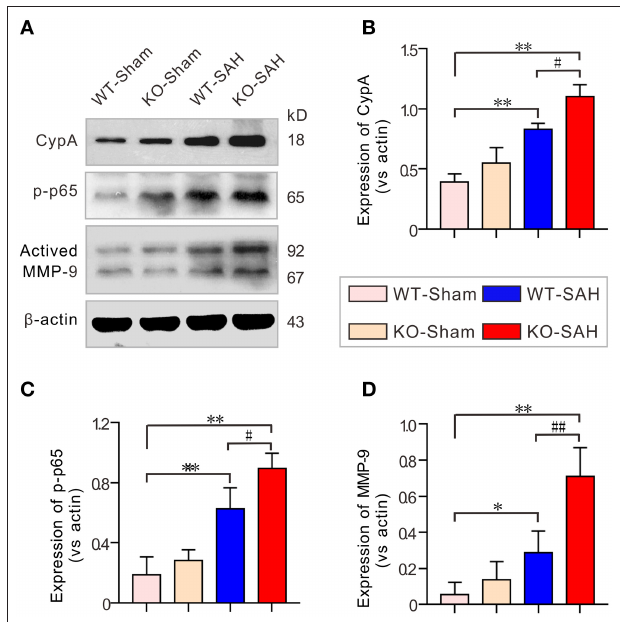
FIGURE 5 | The CypA-NF- κ B-MMP-9 pathway was activated in EBI after SAH. (A) Immunoblotting analysis of CypA, p-p65 and MMP-9 expression in each group 48h after SAH. (B–D) The quantification of CypA, p-p65, and MMP-9. The data are expressed as the mean ± SD, one-way ANOVA